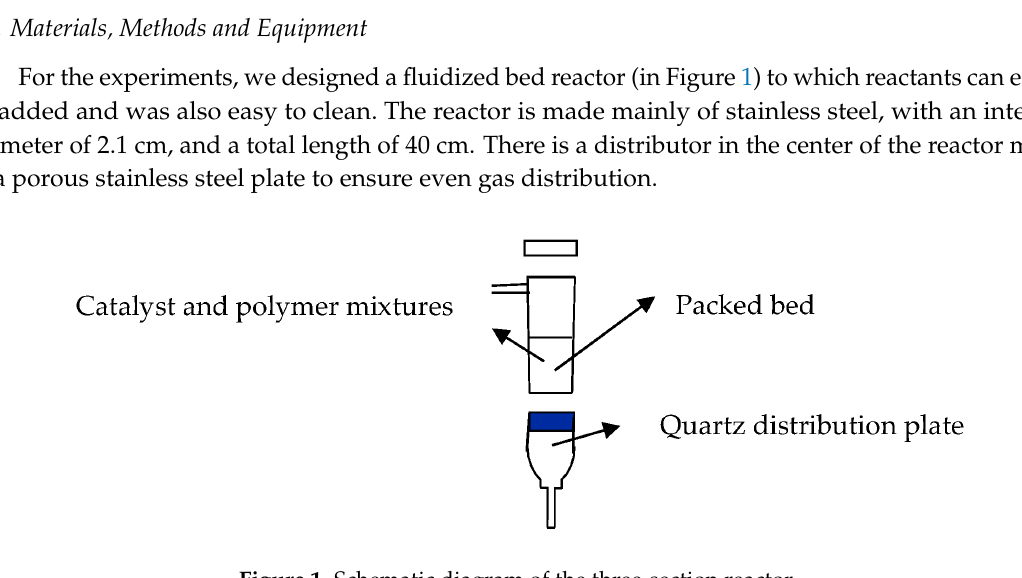
Figure 1. Schematic diagram of the three-section reactor.